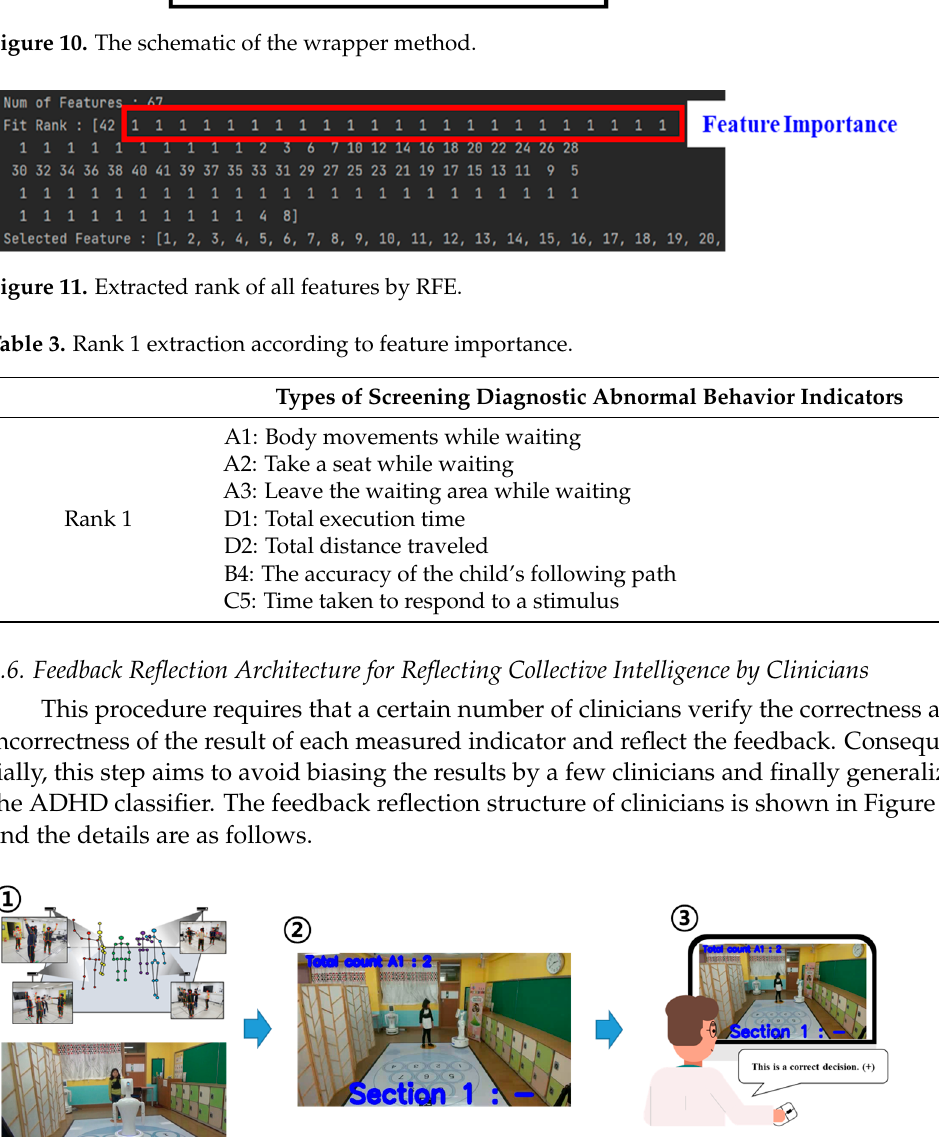
Figure 11. Extracted rank of all features by RFE.